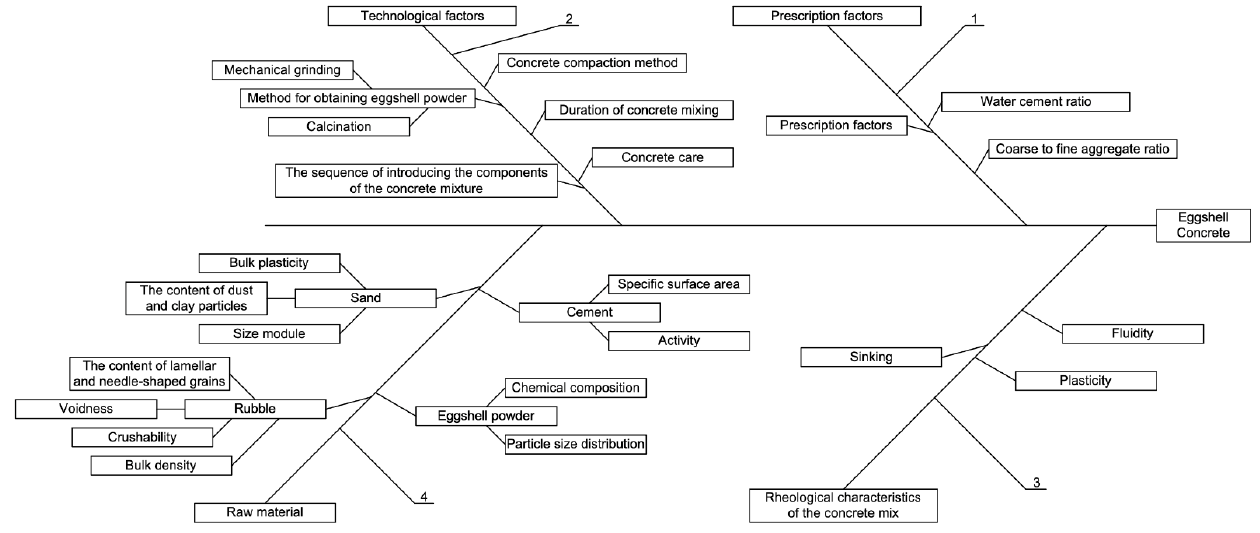
Figure 15. Causal diagram of factors affecting the physical and mechanical properties of concrete modified with ESP additive.